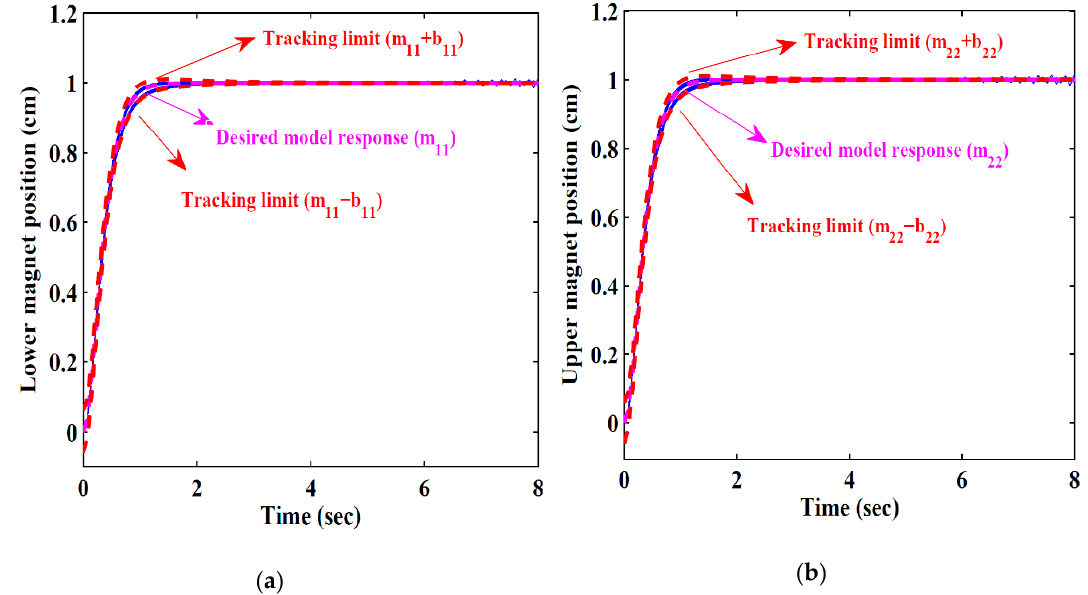
Figure 8. The closed loop (6561 plants) response of the designed control system for ( a ) channel-11 (lower magnet), ( b ) channel-22 (upper magnet).